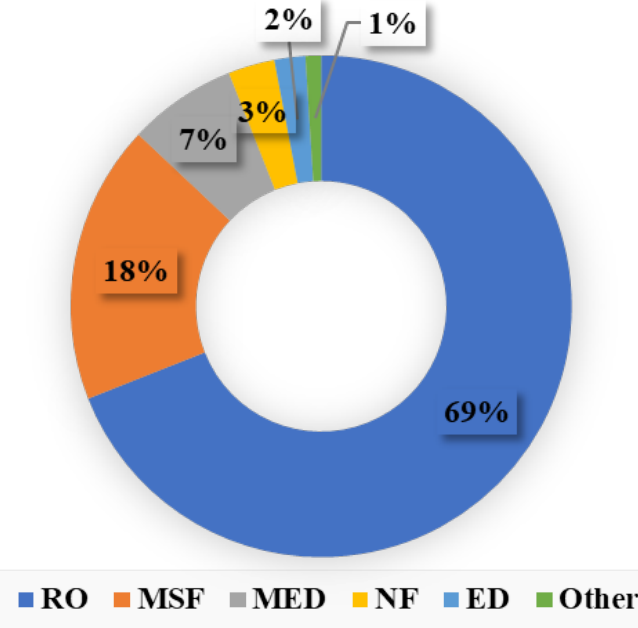
Figure 1. Percentage of desalination facilities worldwide categorized based on different technologies: reverse osmosis (RO); multi-stage flash (MSF); multi-effect distillation (MED); nanofiltration (NF); and electrodialysis (ED) [27,42].